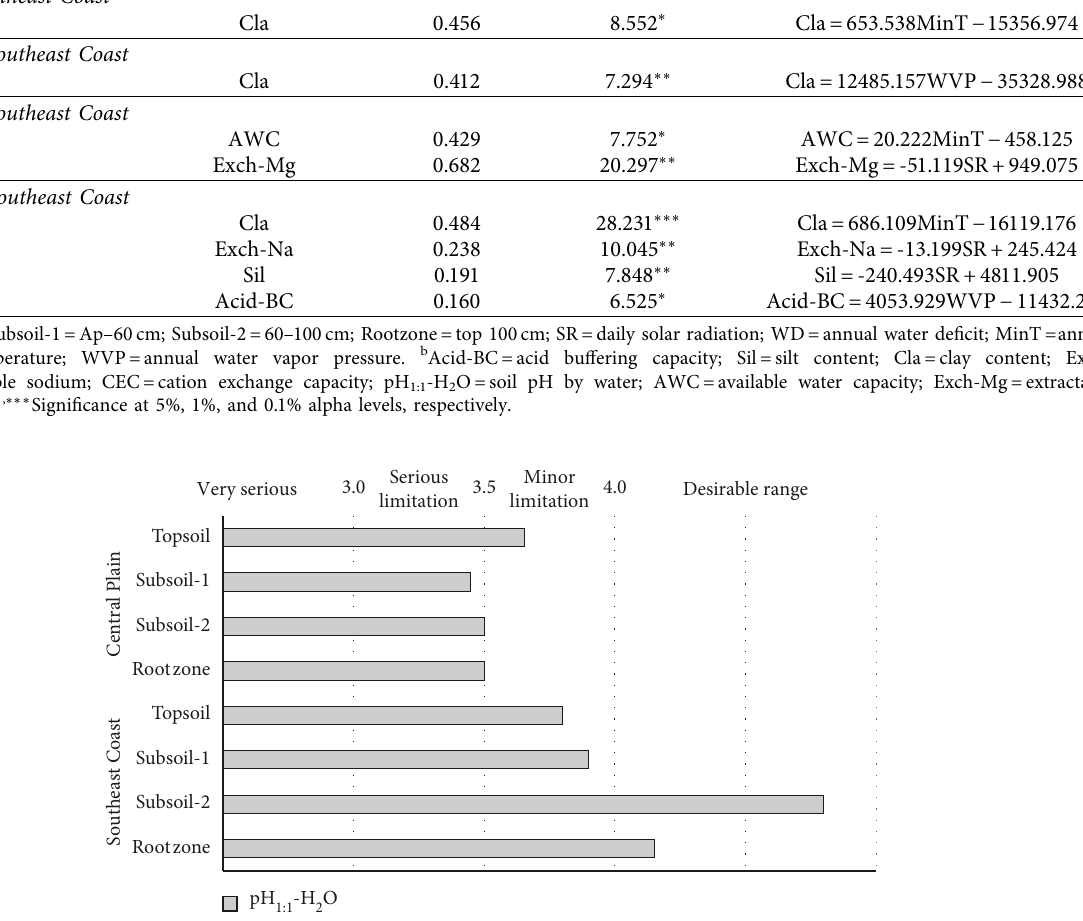
Figure 4: The soil limitation for oil palm of acid sulfate soils under oil palm planting areas in Central Plain and Southeast Coast,